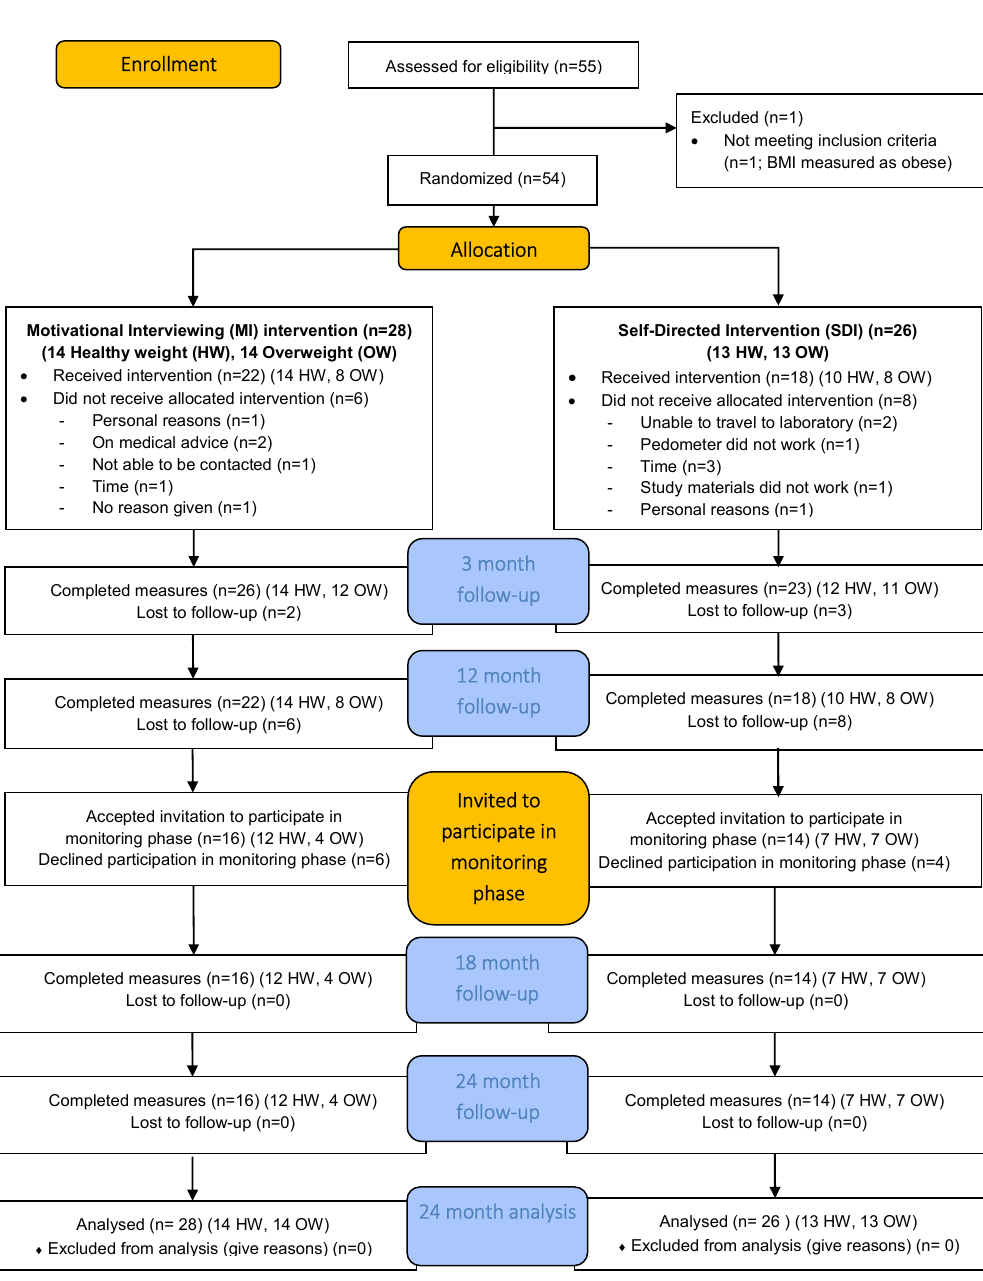
Figure 1. CONSORT flow diagram for the 40-Something study.